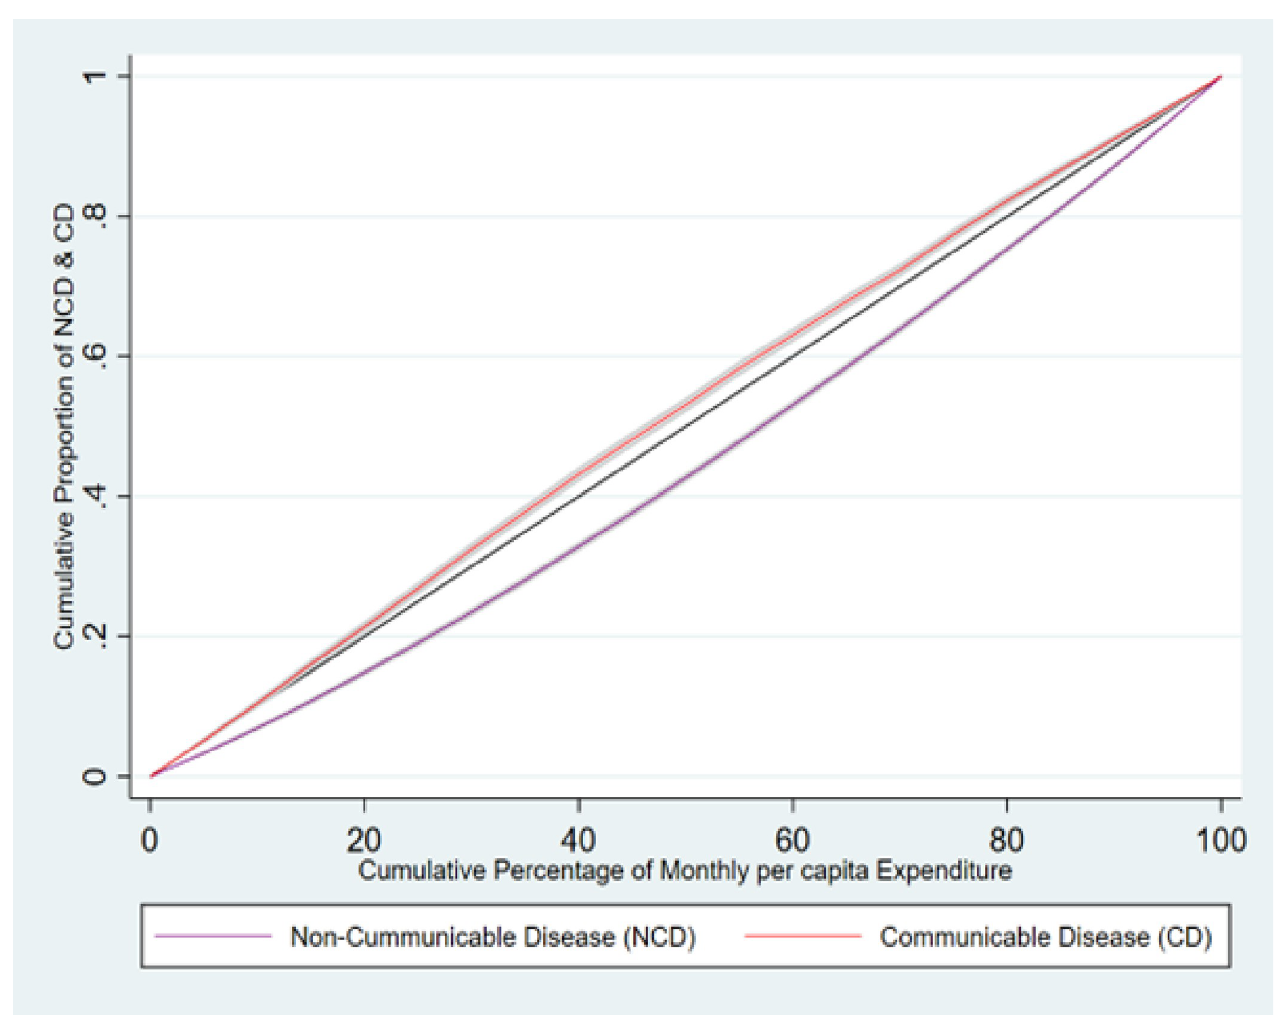
Fig 5. Concentration curve for communicable and non-communicable disease among older adults in India.